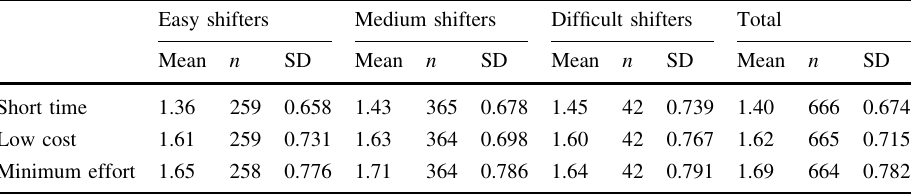
Table 7 Mean values of respondents’ station–campus feeder